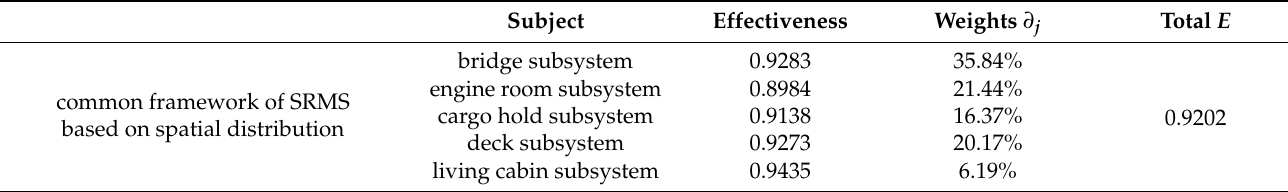
Table 14. Effectiveness value based on the traditional accident probability